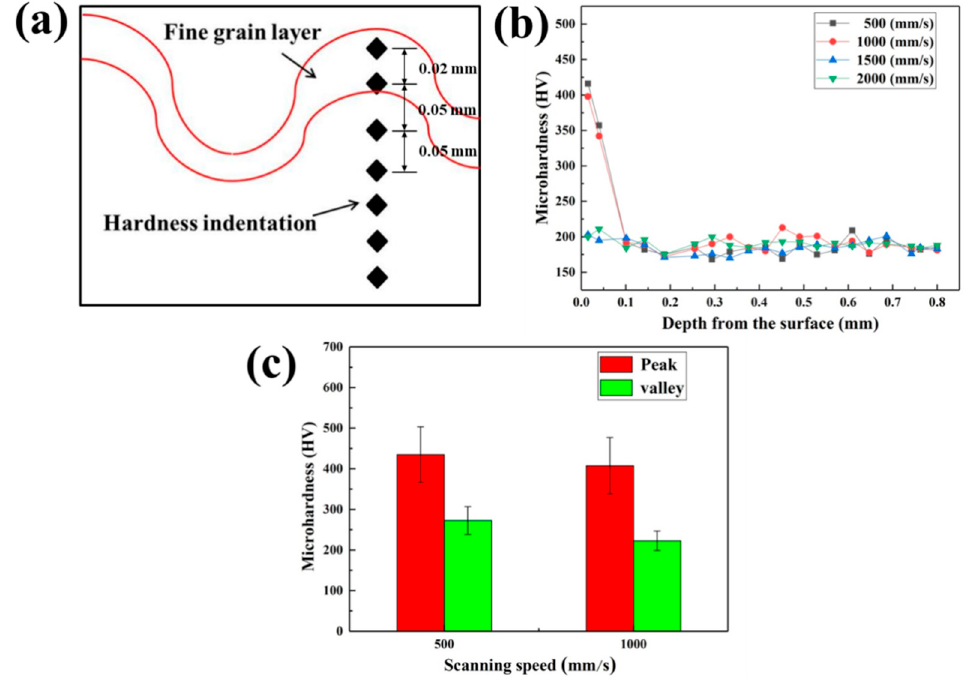
Figure 17. The result of the hardness of the material section. ( a ) The schematic diagram of the position of the hardness indentation; ( b ) The e ff ect of X-scanning speed on the hardness of the material section; ( c ) The result of the hardness of the material section at different position.